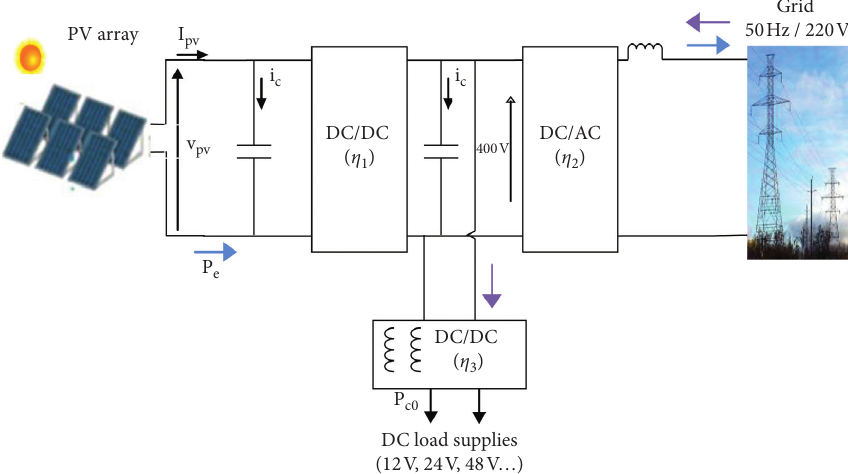
Figure 2: Possible LVDC classical architecture (syst2).